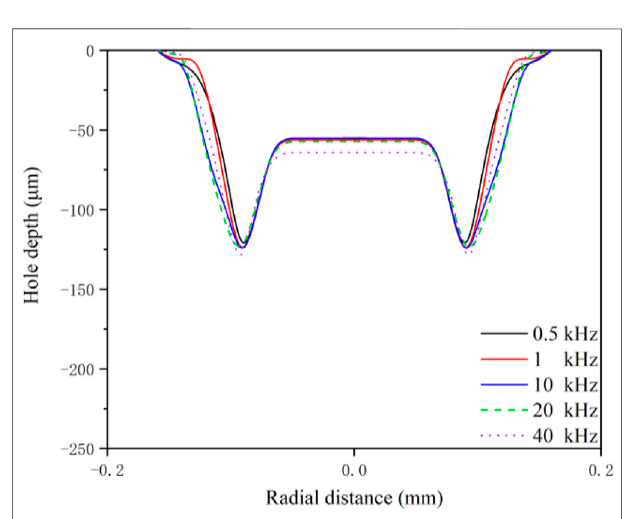
FIGURE 16 | Comparison of cross-section pro fi les with respect to different vibrational amplitudes.